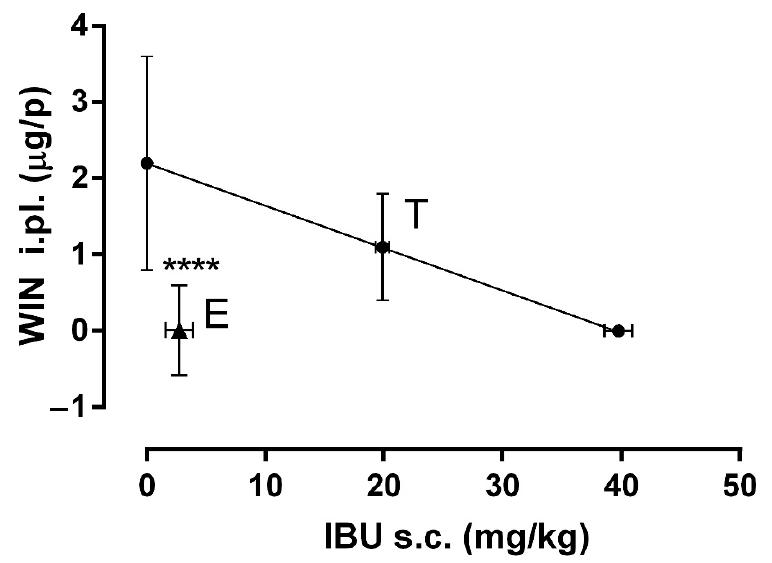
Figure 3. The isobologram showing the interaction between IBU (s.c.) and WIN (i.pl.) in the formalin model. The ED 30 of IBU is shown on the X-axis and the ED 30 of WIN on the Y-axis. The oblique line joining the two ED 30 is the additive theoretical line. The center point of the line indicated by T is the theoretical ED 30 . The point marked as E is the experimental ED 30 calculated from the DRC of COMB. A significant difference between points T and E indicate a supra-additive synergism (**** p < 0.0001). Data are shown as the mean ± SEM of six repetitions.